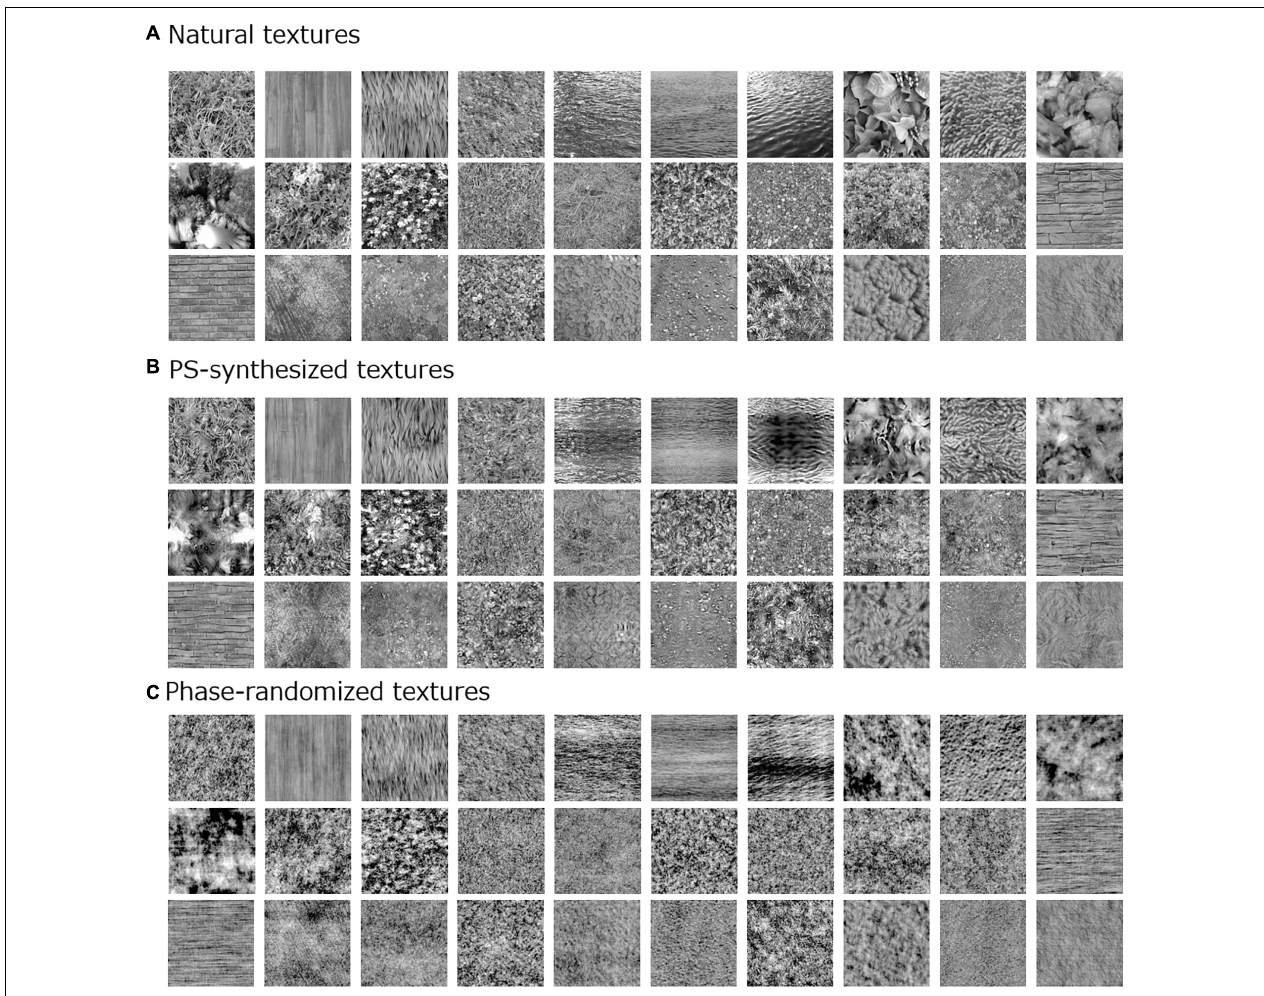
FIGURE 1 | Examples of visual stimuli used in the experiment: (A) natural textures; (B) Portilla–Simoncelli (PS)-synthesized versions; and (C) phase-randomized